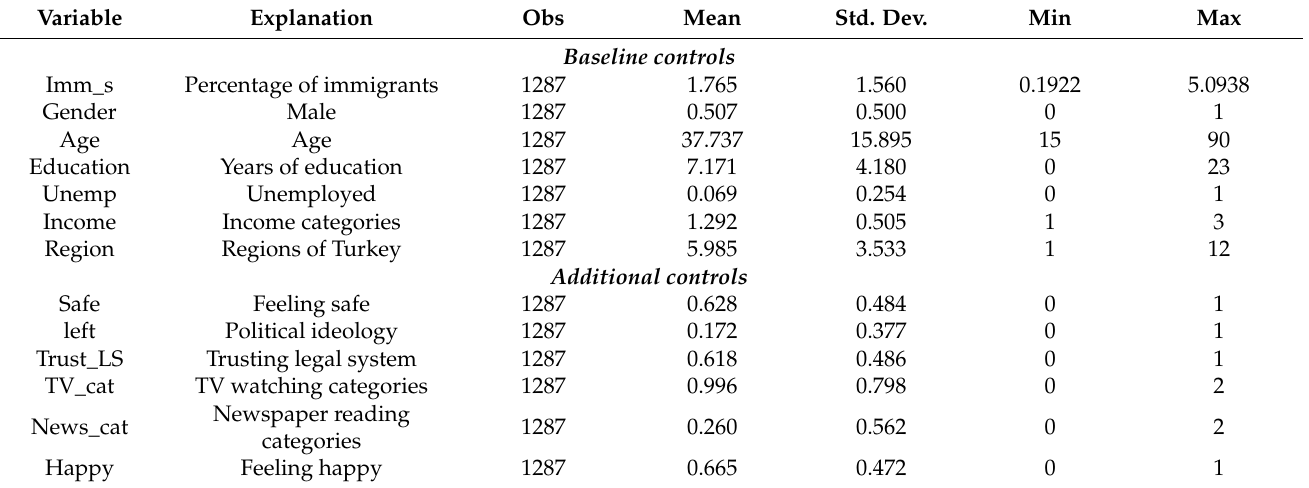
Table 2. Descriptive statistics of independent variables. Source: Author’s calculation based on ESS (Round